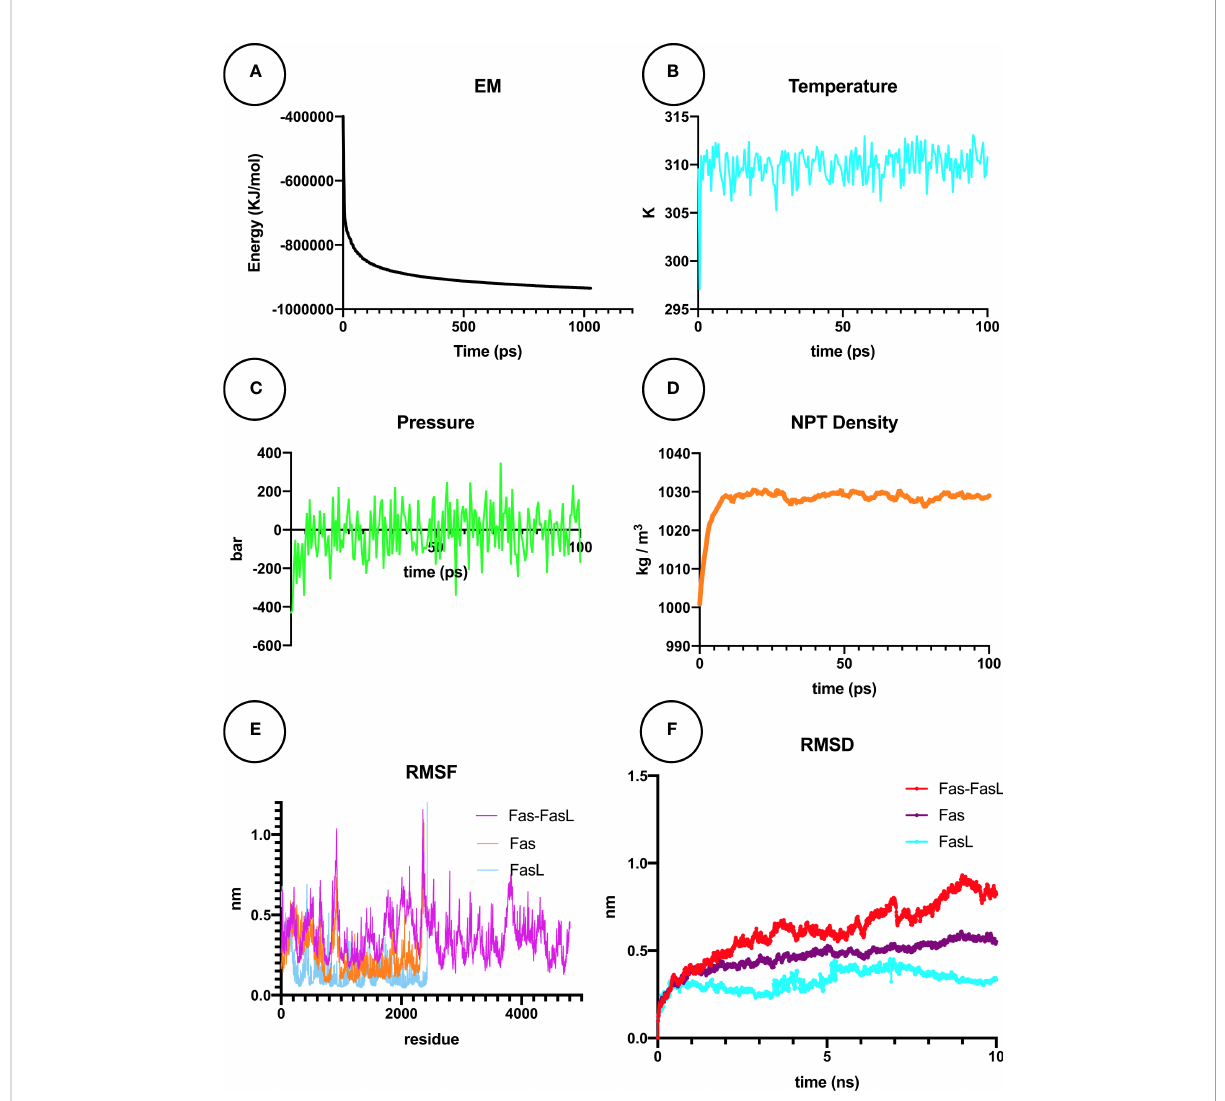
FIGURE 11 Molecular dynamics simulation (MDS) analyses for Fas/FasL in blood MDS is a simulation approach for analysis of the physical movement of atoms. Here, a biological system of Fas/FasL was virtually set up and equilibrated in blood-like conditions, and was allowed a limited time to evolve. (A) Energy minimization (EM) was set-up for the Fas/FasL system. (B) During the NVT equilibration, the temperature was matched to blood-like conditions. (C) During the NPT equilibration, the pressure reached 0 bar. (D) Density of the Fas/FasL system was also equilibrated in this step. After production MDS of the Fas/FasL system: (E) Root-mean square fl uctuation (RMSF) analysis did not show fl uctuation in the Fas/ FasL system and the proteins did not denature. (F) Root-mean square deviation (RMSD) values shows that the Fas/FasL complex reached stability within the blood-like simulation conditions.